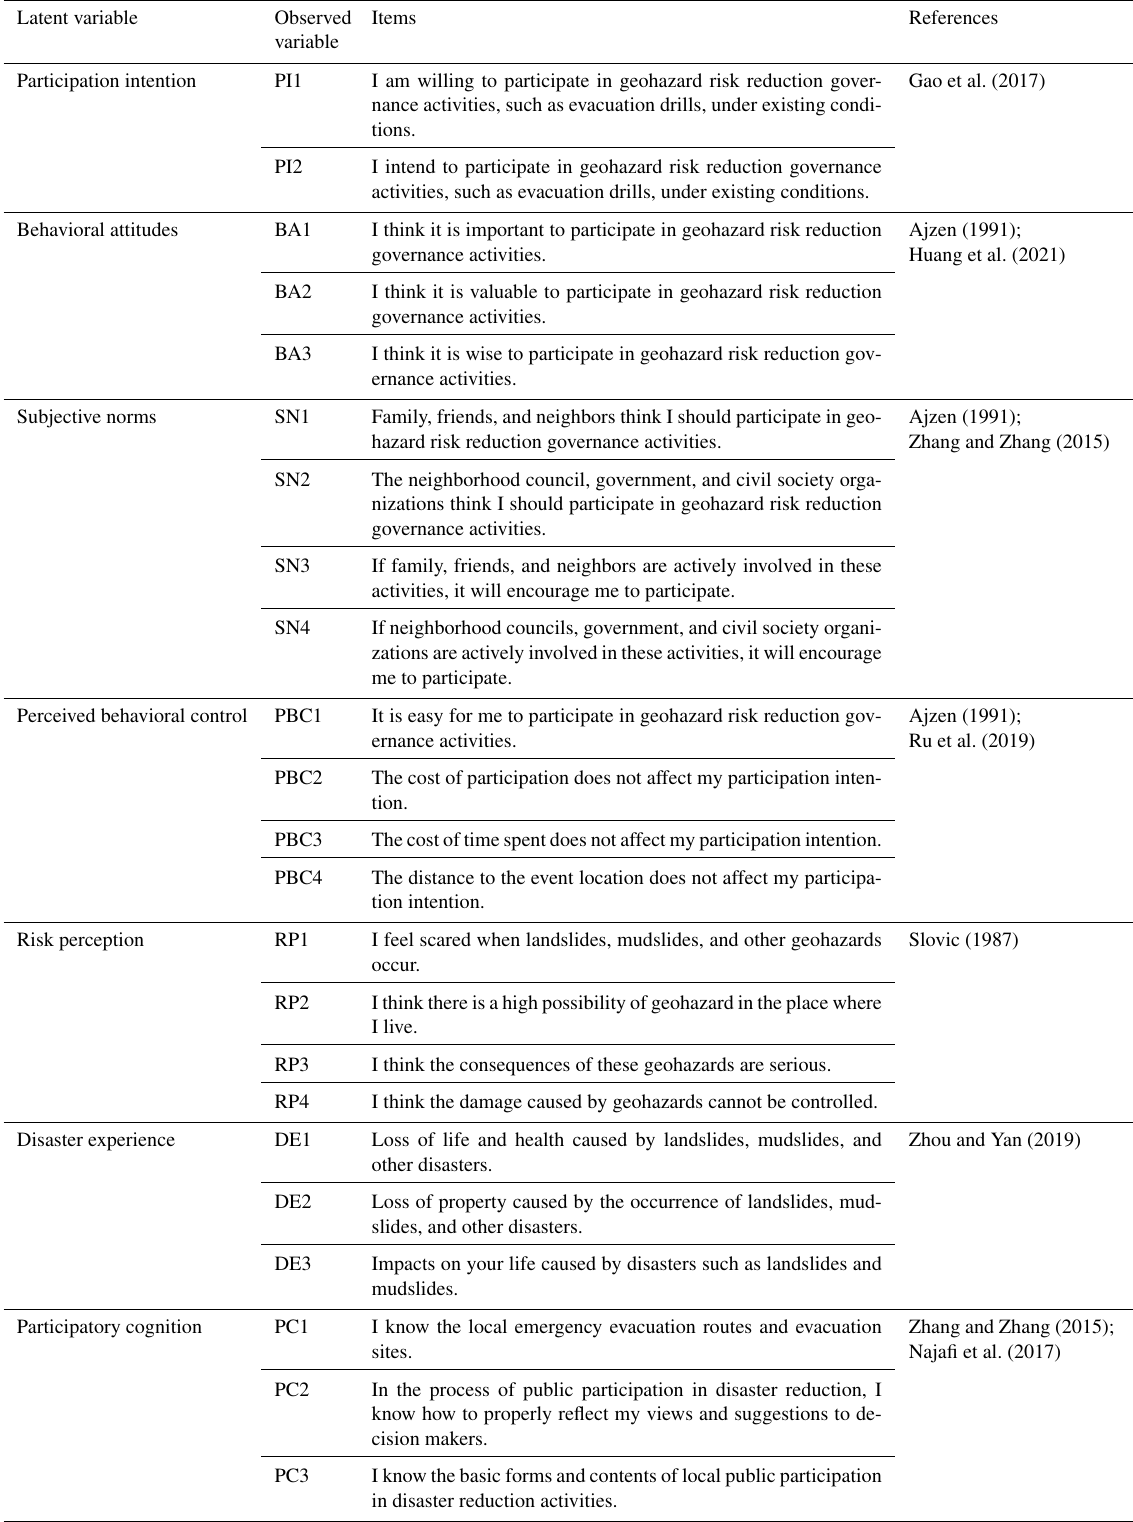
Table 1. Questionnaire measurement